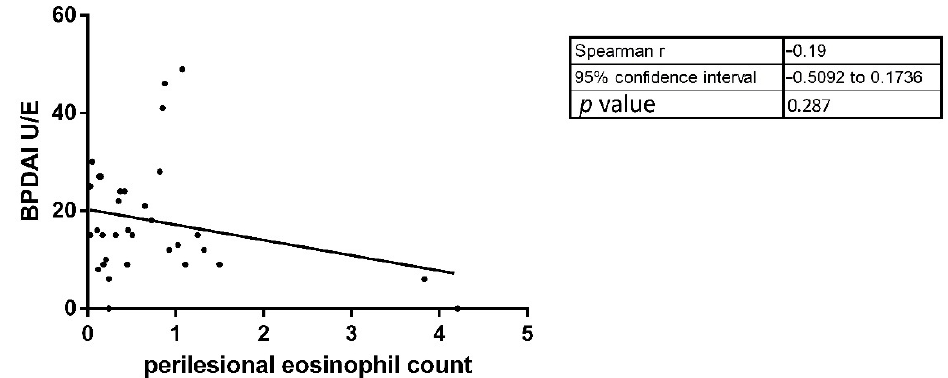
Figure 4. The correlation between the periblister eosinophil count and the BPDAI U/E value was also not significant.